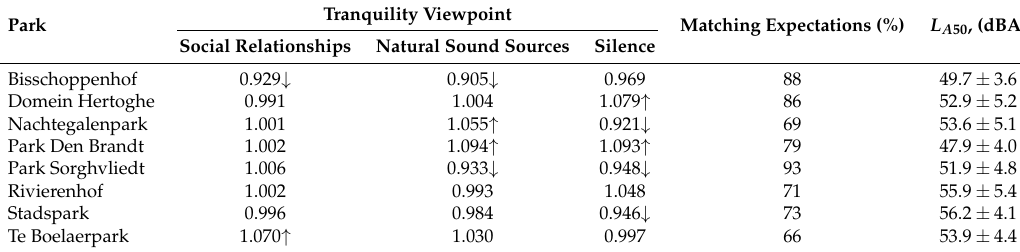
Table 3. Membership of the tranquility viewpoint groups normalized to indicate in which parks persons adhering to these viewpoints are found more often than average (arrows point to difference of more than 5% to overall average). Matching expectations are shown with the percentage of the visitors that stated “agree” or “completely agree” on the questionnaire statement “the sounds in this park are the sounds that one expects to hear in a park” (Section 3.4). The last column presents the average and standard deviation of the 50-percentile A-weighted sound pressure level from data aggregated over the whole park (Section